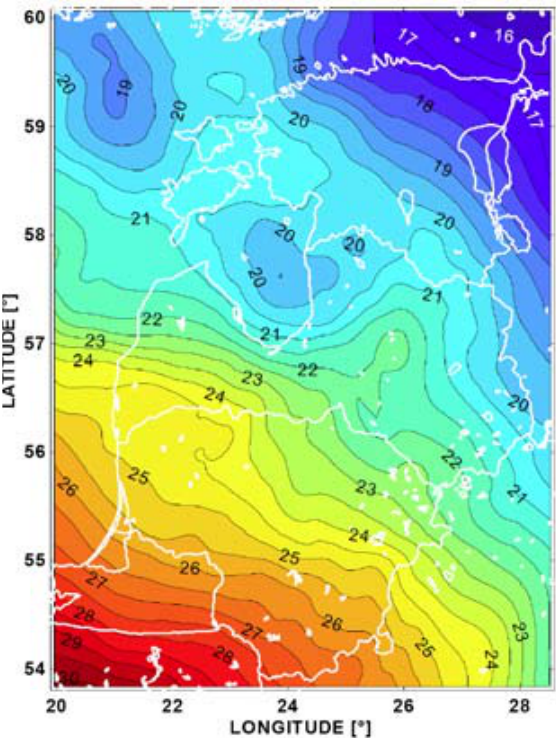
Fig. 1. The 1.5´×3´ Baltic gravimetric geoid model BALTgeoid-04 (Ellmann 2004). Geoidal heights are given with respect to the GRS-80. Unit is metre and the contour interval is 0.5 m. The total area of the image corresponds